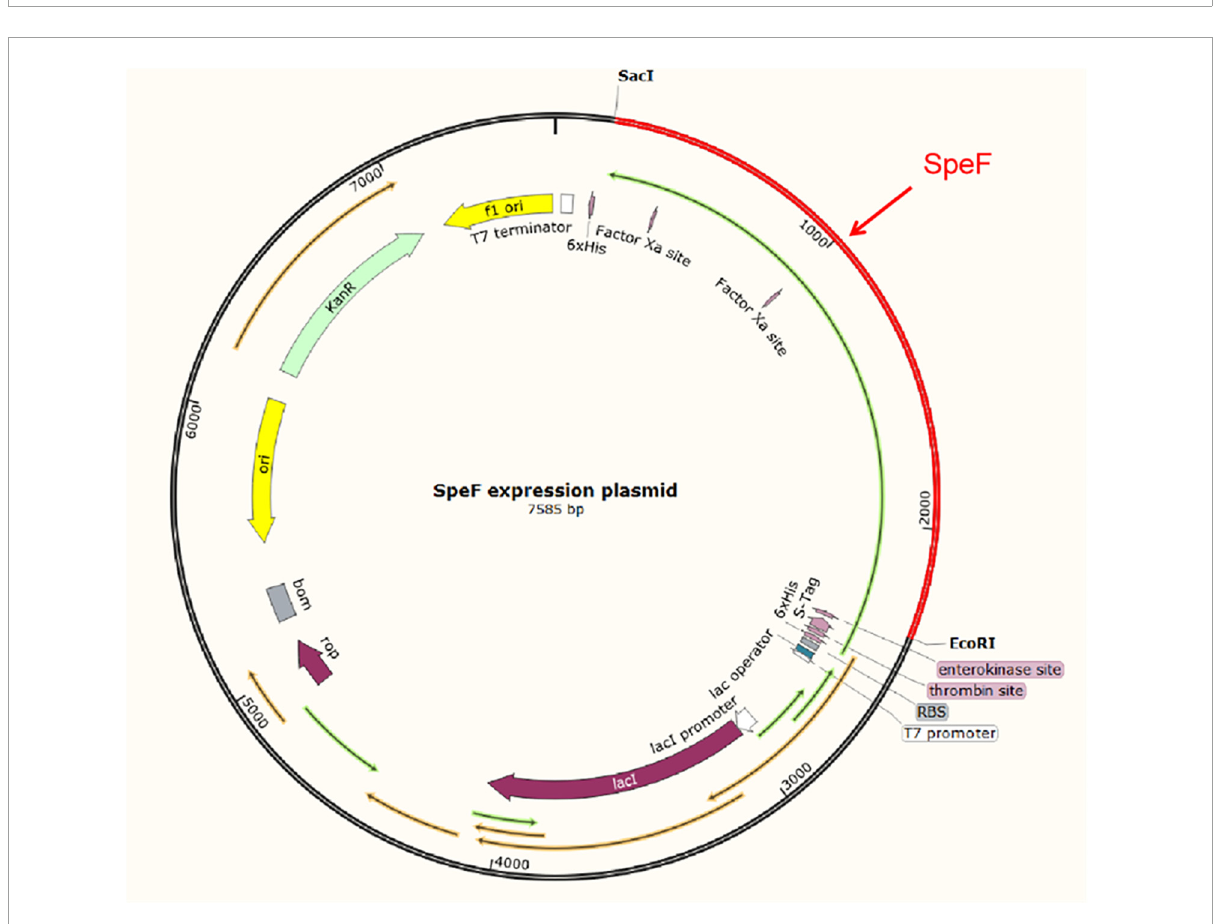
FIGURE4 The schematic diagram of the pET-30a-SpeF recombinant plasmid. The Sac I and Eco RI were selected as restriction sites.